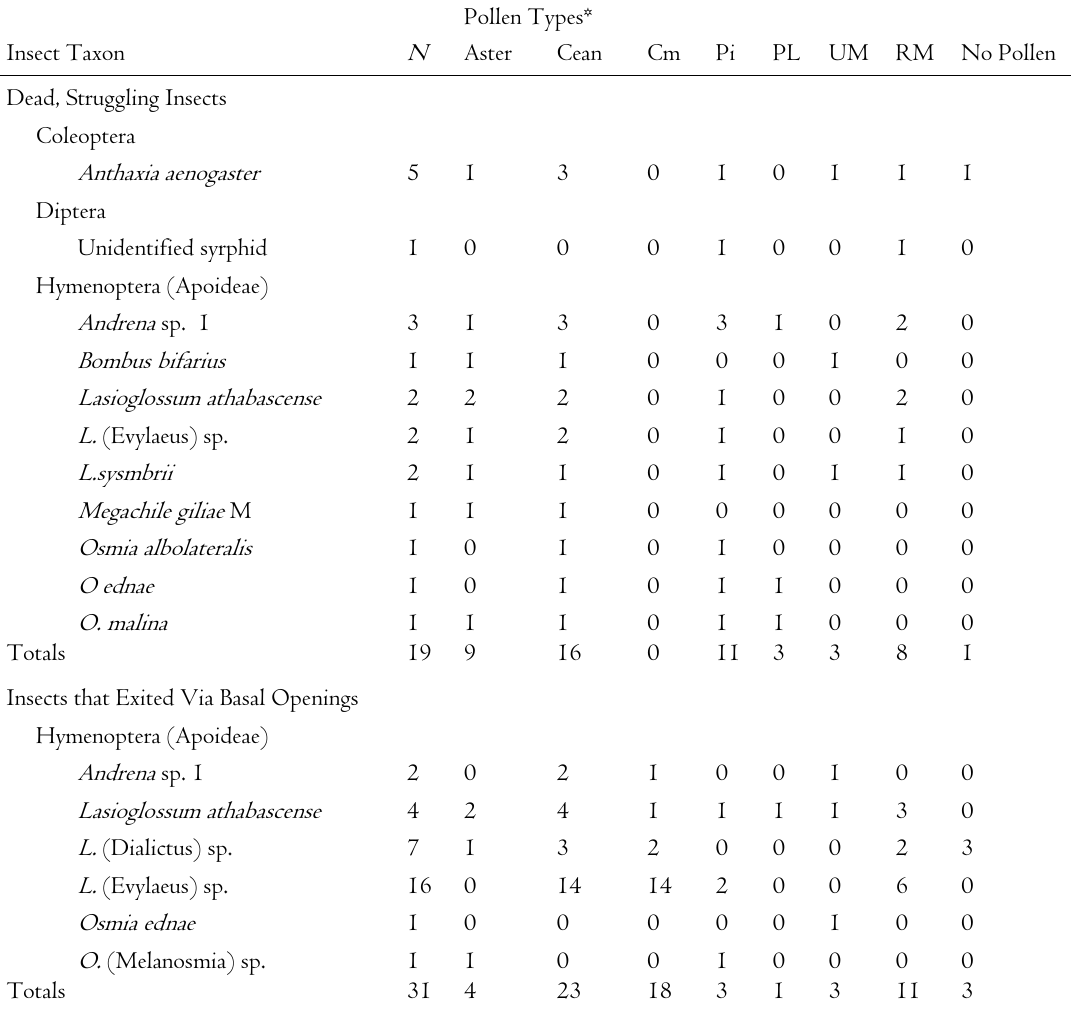
Table 5. Pollen load analyses of insects collected at the ECCO site combining dead-struggling specimens with specimens that exited through the basal